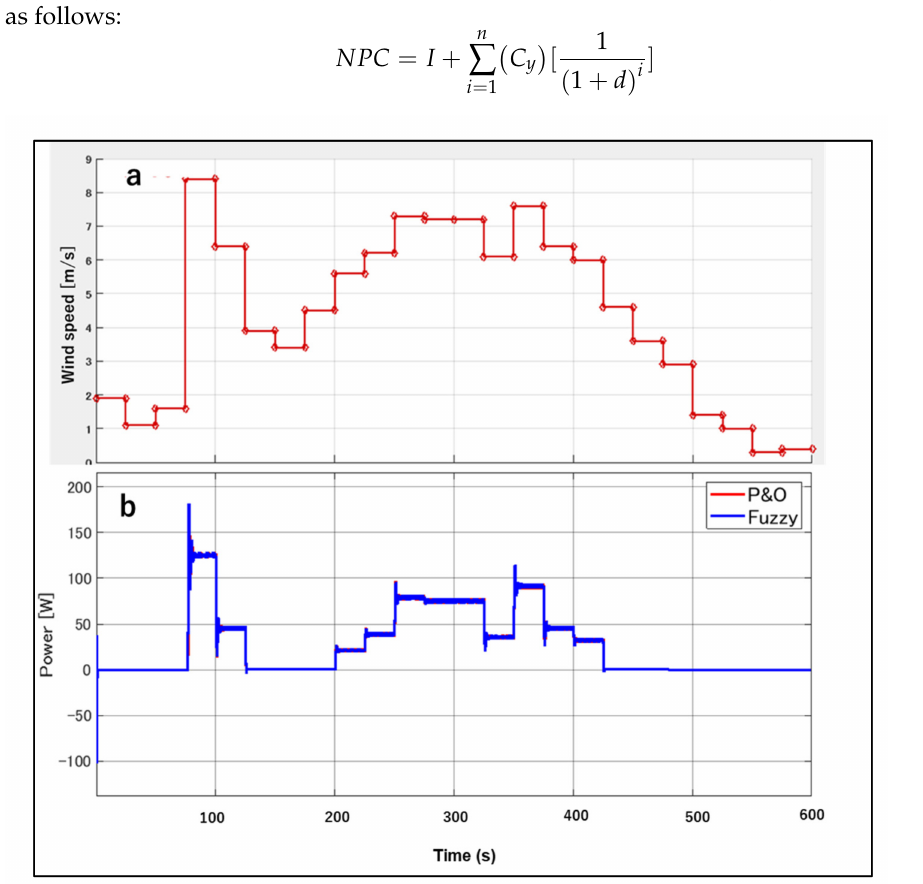
Figure 20. Comparison between the FLC-based and P&O-based MPPT systems for the wind turbine (windy day); ( a ) Wind speed; ( b ) Output power. Table 8. Surplus output power from the FLC-based MPPT compared to the P&O-based MPPT. P&O Power Fuzzy Month [kWh]